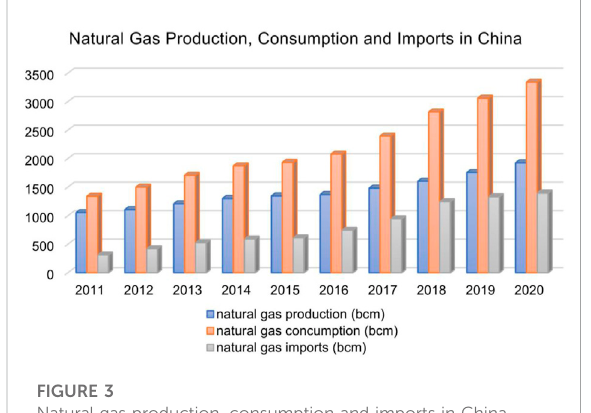
FIGURE 4 China ’ s natural gas imports in 2017 –